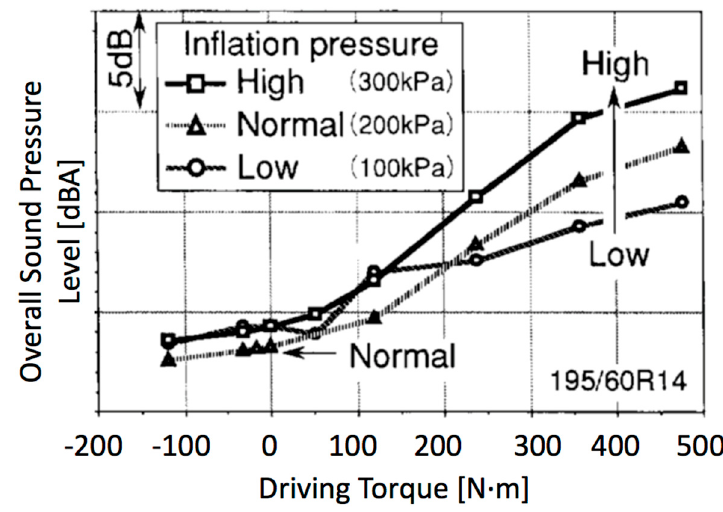
Figure 3. Changes of TPIN due to driving torque and inflation pressure (modified from Iwao and Yamazaki, 1996 [36], Figure 7).